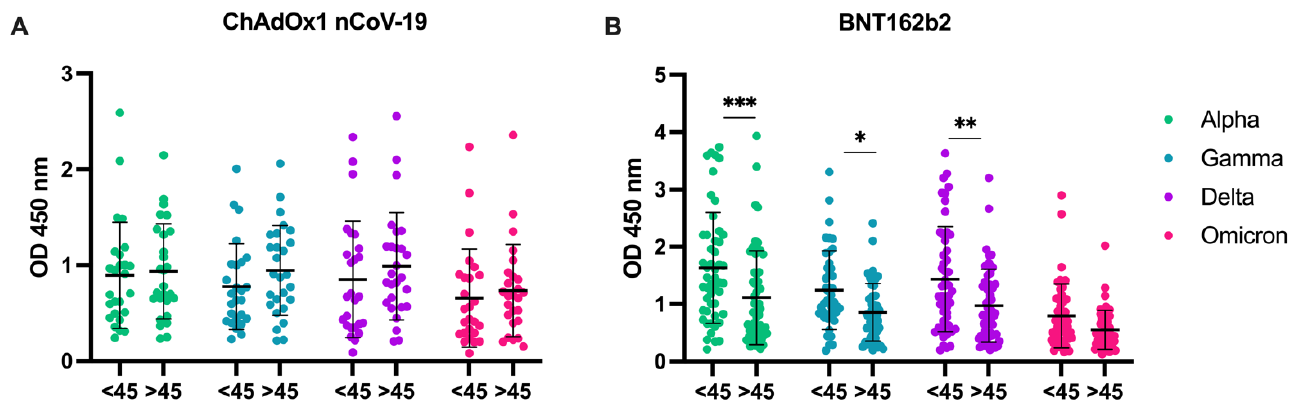
either ChAdOx1 nCoV-19 (Panel A ) or BNT162b2 (Panel B ). ther ChAdOx1 nCoV-19 (Panel A ) or BNT162b2 (Panel B ).